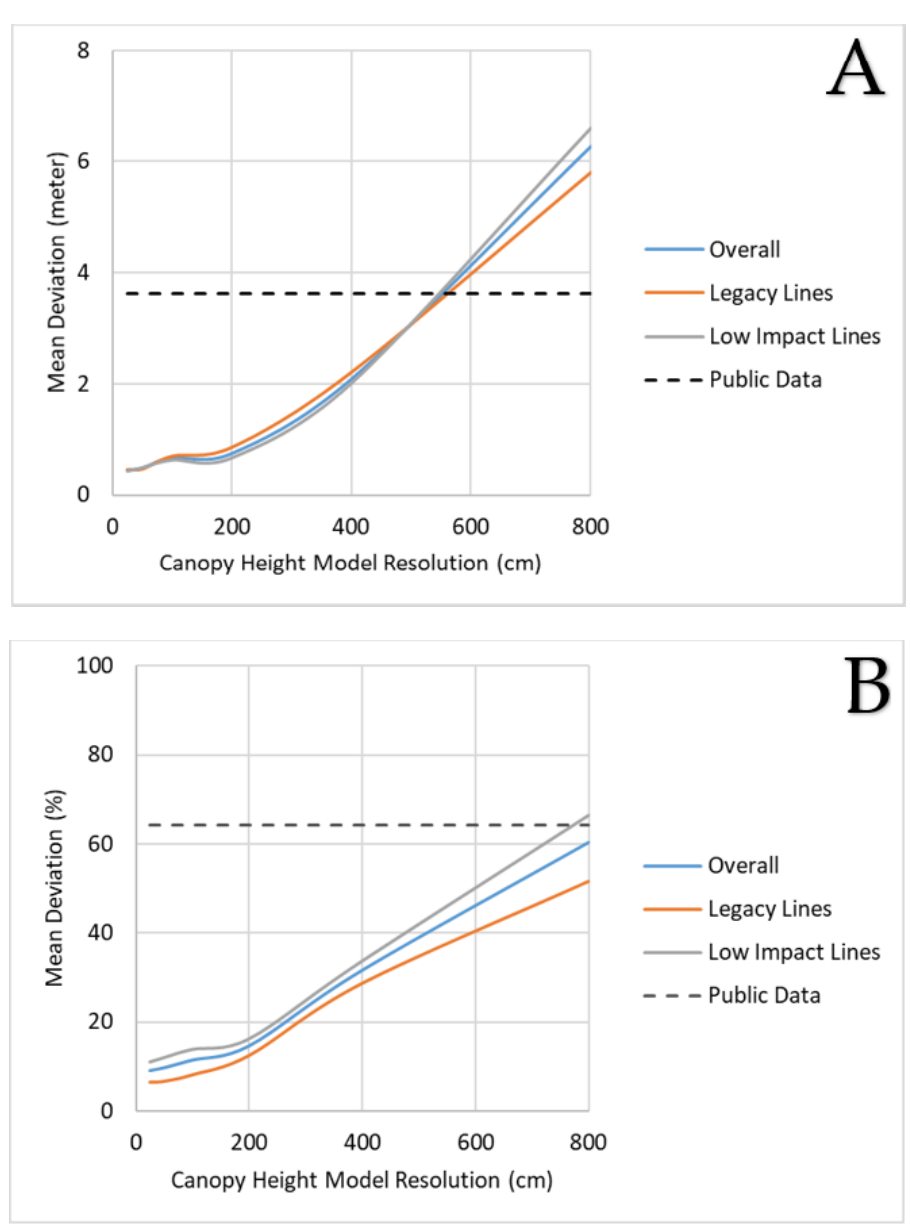
Figure 8. Mean deviation of mapped centerlines from field-measured center points expressed in absolute units ( A ) and percentages relative to line width ( B ) for different input CHM resolutions. Dashed lines show the accuracy of the best publicly available linear-feature datasets in our study sites.